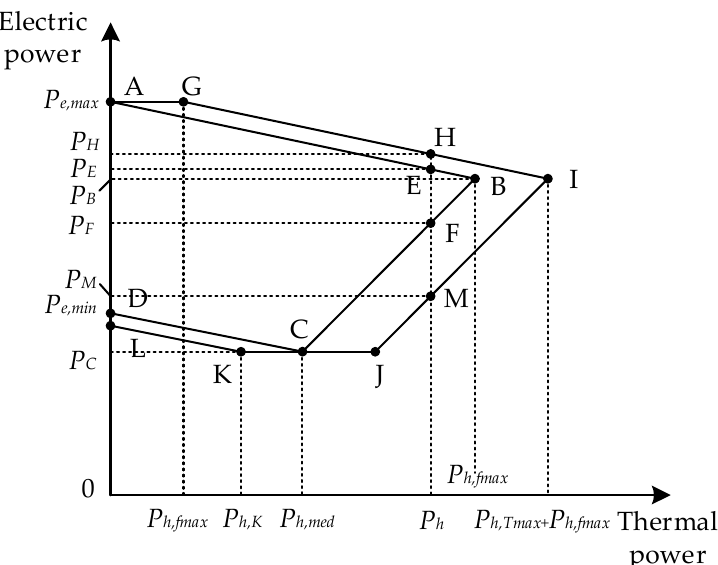
Figure 2. Electric and thermal characteristics of conventional cogeneration unit with heat storage. 122